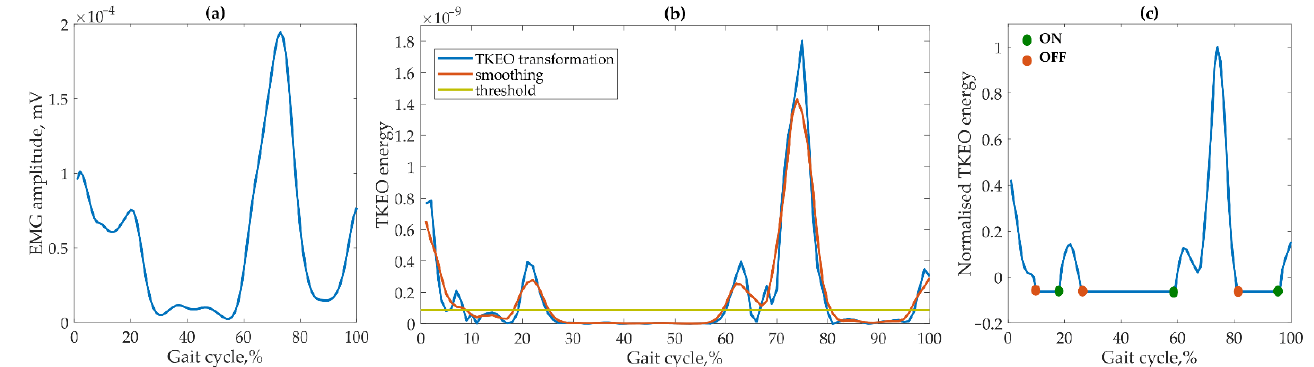
Figure 2. Stages of EMG data processing: ( a ) pre-processed EMG; ( b ) TKEO transformation, smooth- ing, and threshold determination; ( c ) normalization to MVC and onset/offset detection.